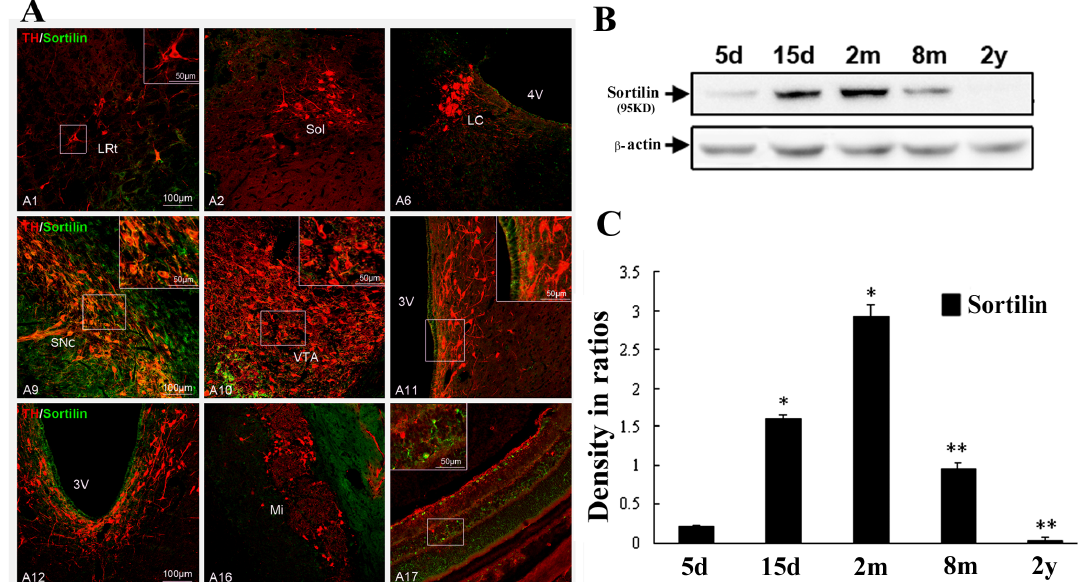
Figure 5. Abundant distribution of sortilin/TH neurons and age-related changes in the substantia nigra. ( A ) Distribution patterns of TH/sortilin-positive neurons in all A1–A17 cell groups of whole rat brains. TH-, sortilin-, and TH/sortilin-positive neurons are shown in A1, A2, A6, A9, A10, A11, A12, A16 and A17 areas, representatively; ( B ) Immunoblotting of sortilin expression in the substantia nigra of postnatal 5 days, 15 days, 2 months, 8 months and 2 years old; and ( C ) Comparison of sortilin expression levels in the substantia nigra in ratio to β -actin. ANOVA test indicates significance, * p < 0.005, ** p < 0.001 vs. earlier